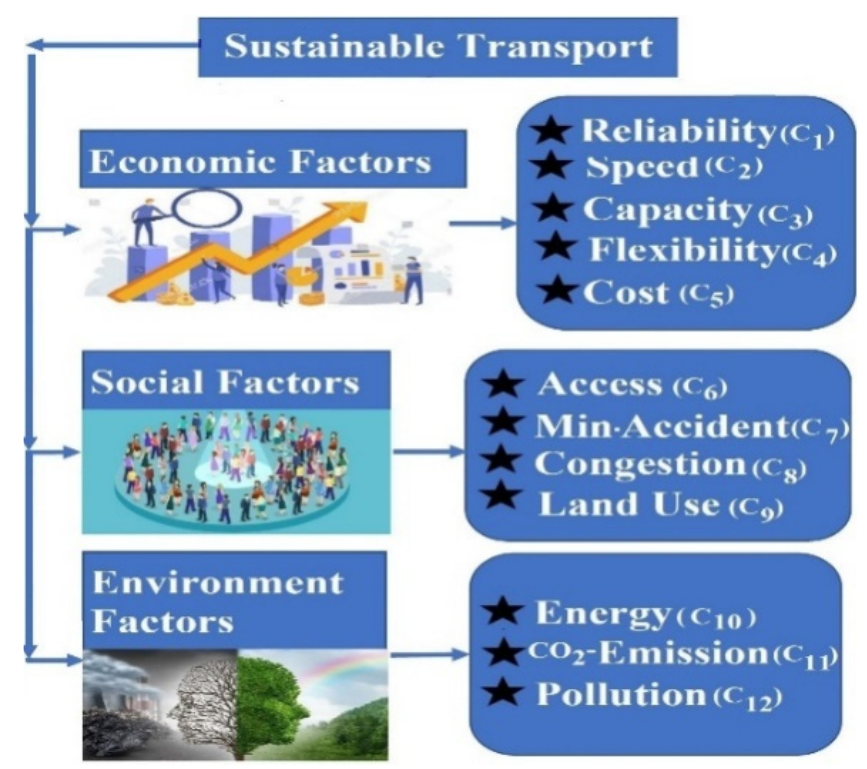
Figure 5. Leading scenarios and attributes for sustainable transportation.